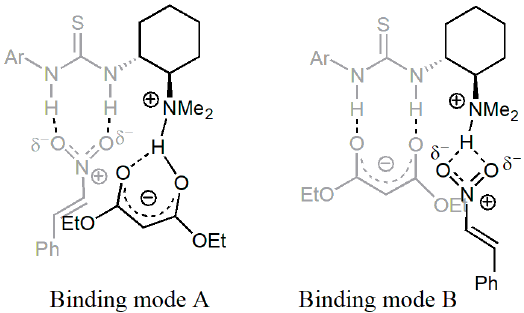
Figure 3. Possible binding modes initially selected by Pápai [19].